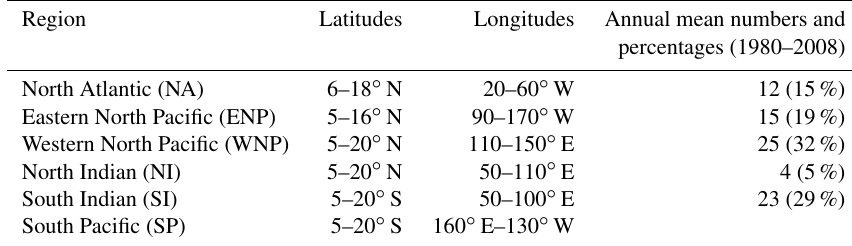
Table 2. Definitions of regions and numbers of observed